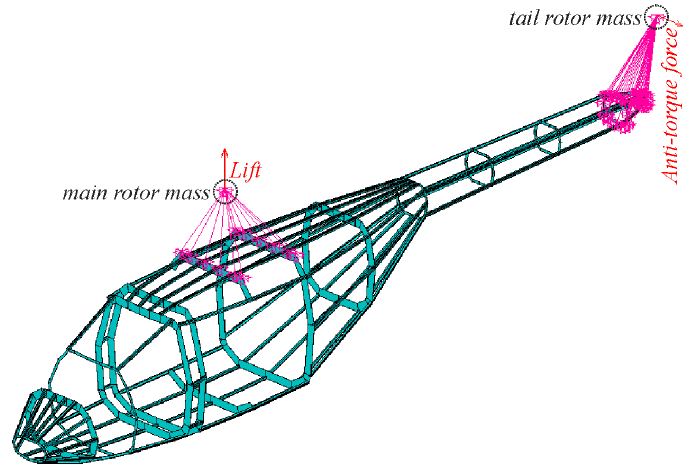
Figure 21. Force and mass constraints.